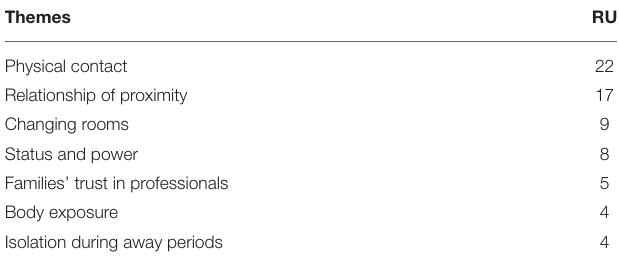
TABLE 6 | “Risk factors in sports settings” dimension’s